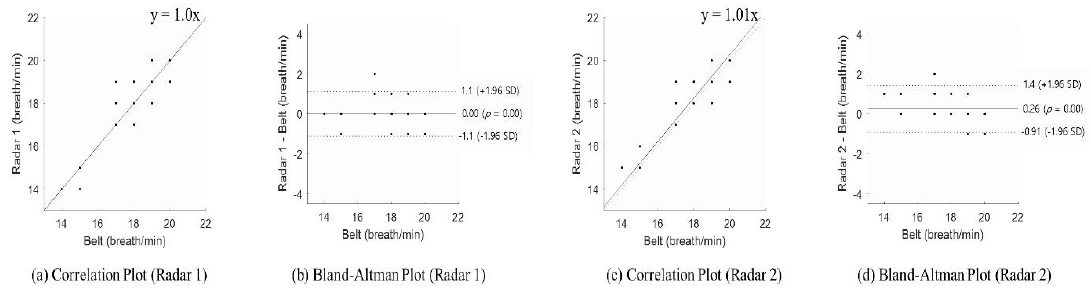
Figure 7. Statistical evaluation of both radar sensors: ( a ) correlation plot for radar 1, ( b ) Bland–Altman plot for radar 1, ( c ) correlation plot for radar 2, and ( d ) Bland – Altman plot for radar 2.